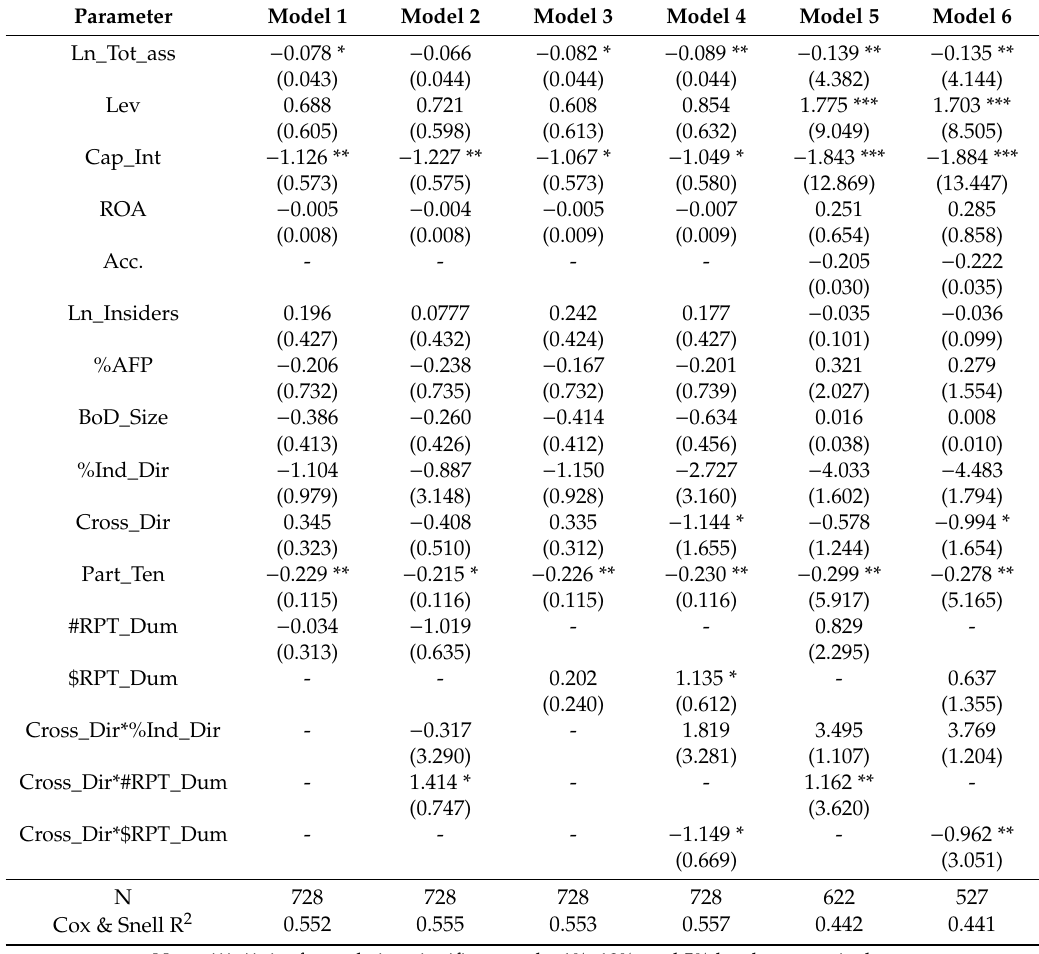
Table 4. Logistic regression of board links, partner tenure, and related party transactions on misstatements (Wald statistics shown in